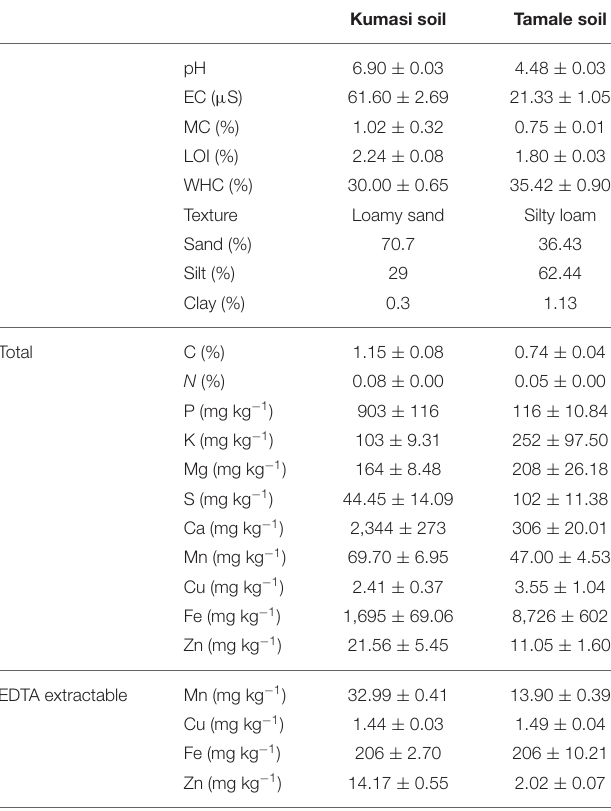
TABLE 1 | Chemical and physical properties of the soil samples (mean ± S.D. n = 3).